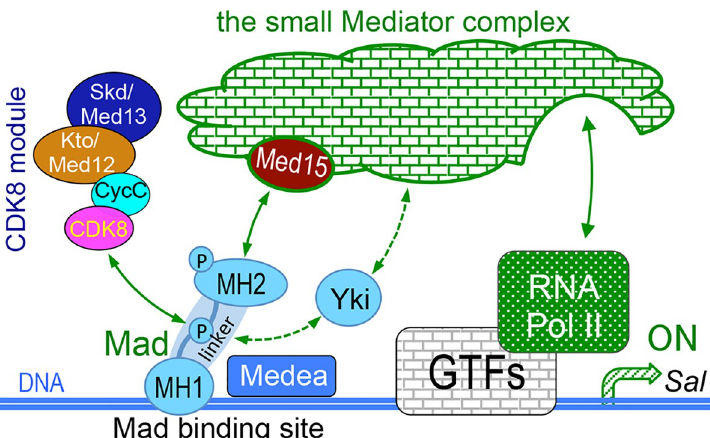
Fig 9. Working model. Model of Mad/Smad-dependent transcription activation through the CKM and the Mediator complex. GTFs, General Transcription Factors; MH1, Mad homology 1; MH2, Mad homology 2.